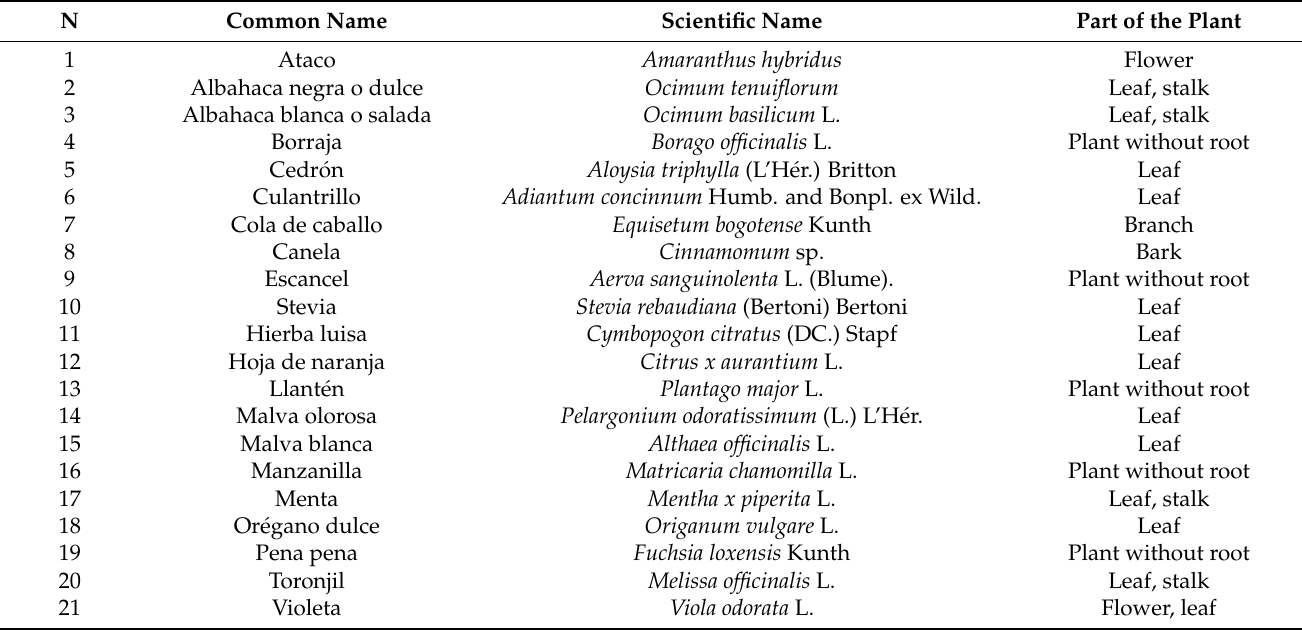
Table 7. List of horchata plants and parts of the plants used in this